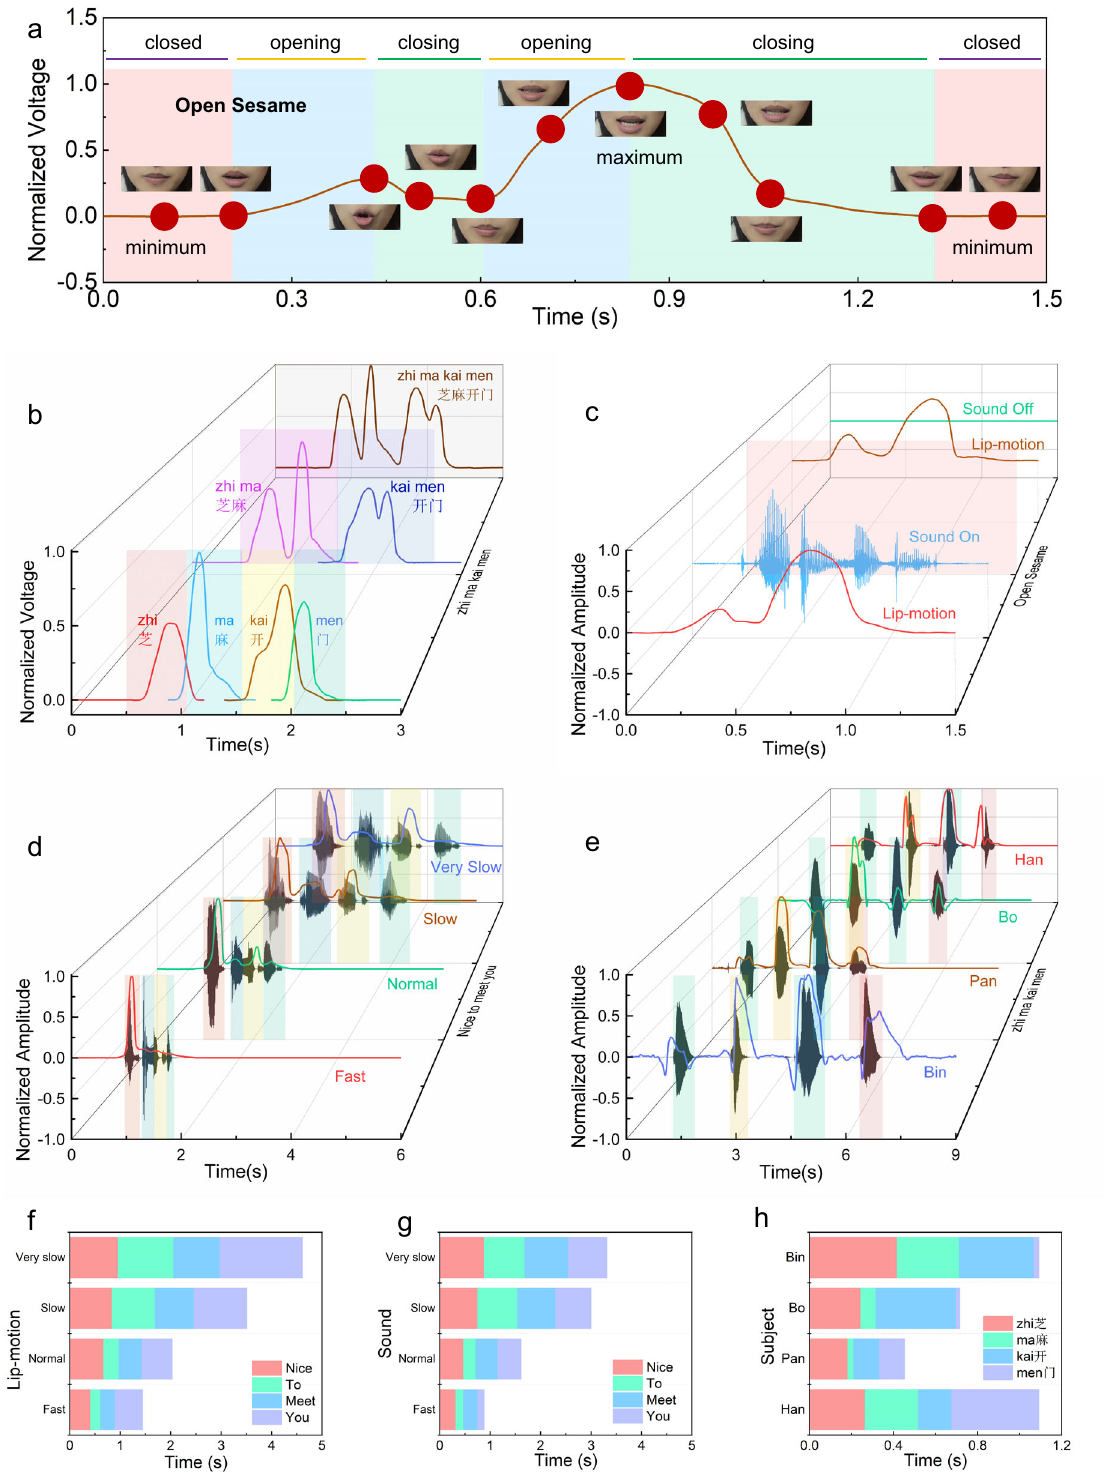
Fig. 3 Signals generated by mouth muscles and a comparison of sound and lip-motion signals. a In a typical speaking sequence ( “ Open Sesame ” ), the mouth shape synchronizes with the signal, and the regions separated by the mouth state are denoted as closed, opening and closing. b The combined and decomposed lip-motion signals for “ Zhi ” , “ Ma ” , “ Kai ” , “ Men ” , “ Zhi Ma ” , “ Kai Men ” , and “ Zhi Ma Kai Men ” . c The lip-motion signals for silent and vocal speaking remain the same, and sounds are recorded synchronously when speaking “ Open Sesame ” . d Sound and lip-motion signals are collected simultaneously at four speeds of reading “ Nice To Meet You ” . e Sound and lip-motion signals collected simultaneously when four participants (Han, Bo, Pan and Bin) read “ Zhi Ma Kai Men ” . f The time used for lip-motion signals for each word in “ Nice To Meet You ” at four different reading speeds. g The time used for sound signals for each word in “ Nice To Meet You ” at four different reading speeds. h The time statistics for the lip-motion signals ahead of the sound signals for each word in “ Zhi Ma Kai Men ” spoken by four